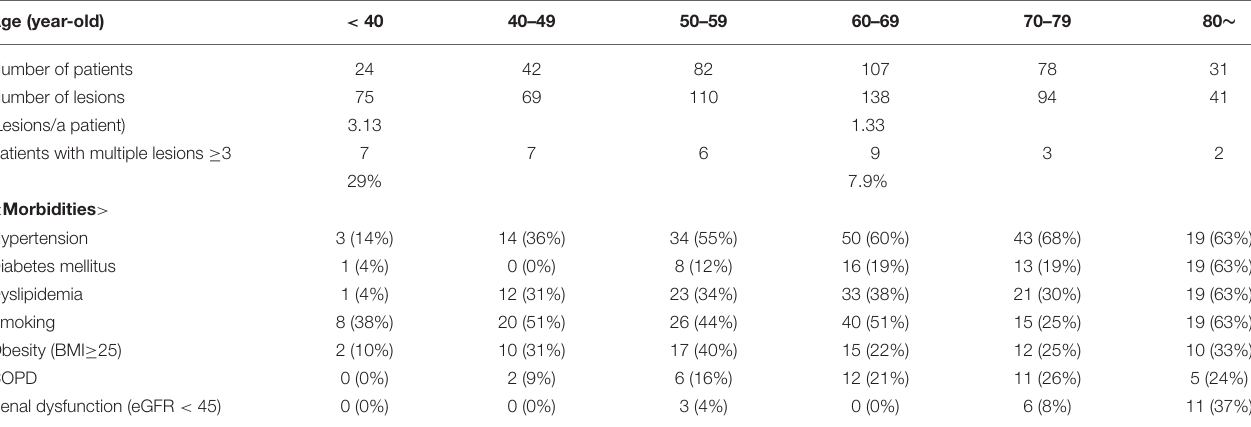
TABLE 1 | Characteristics of the study